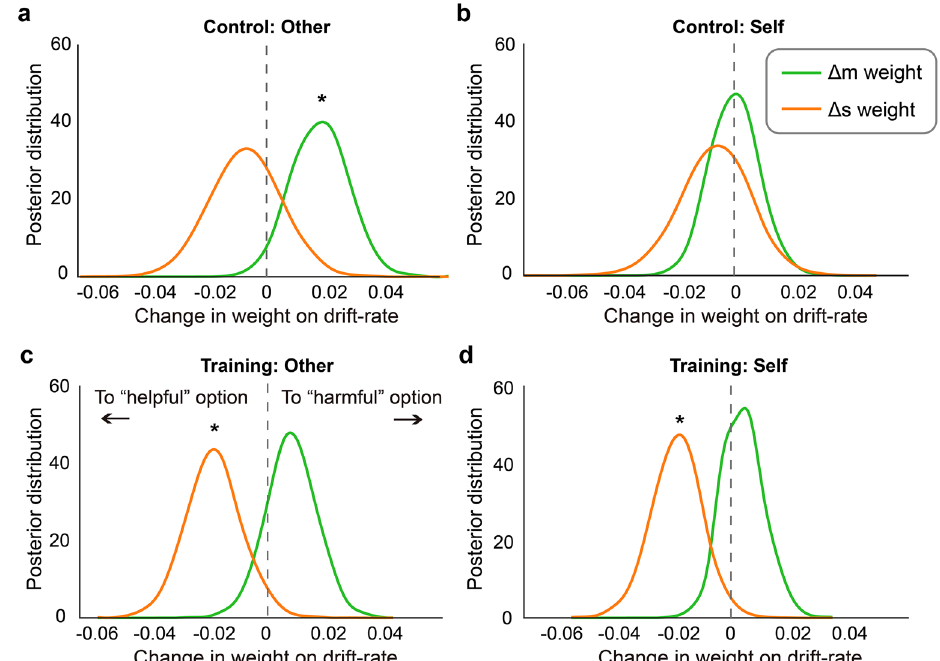
Figure 4. Results of drift–diffusion modeling analysis. Four separate models were estimated on the Other trials of the Control Group ( a ), the Self trials of the Control group ( b ), the Other trials of the Training Group ( c ), and the Self trials of the Training Group ( d ). For the Control group, the weight of Δm on drift rate significantly increase from the Pre- to the Post-training session in the Other condition, but not in the Self condition. For the Training group, the weight of Δm on drift rate did not change significantly between the Pre- and Post-training sessions for both the Self or the Other condition. Asterisks indicate that 0 is outside of the 95% credible interval of the